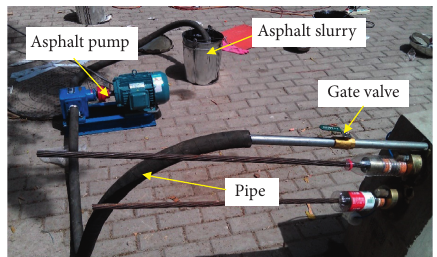
Figure 4: Grouting experiment of the asphalt-based material in concrete beam.